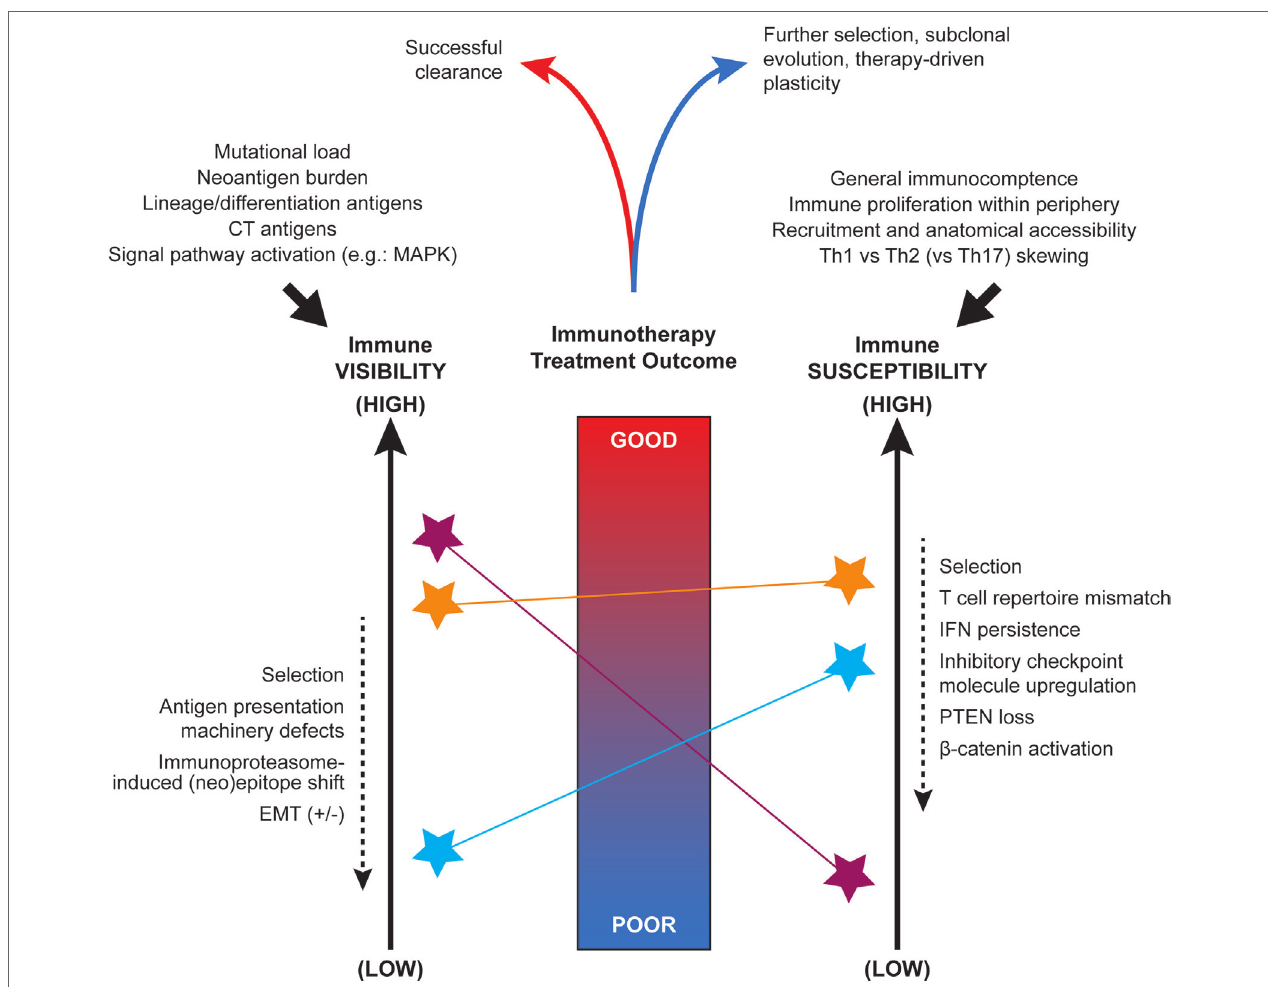
FiGURe 1 | Factors influencing the immune visibility and susceptibility of tumors. Nomogram-conceptualization of the competing influences of tumor immune visibility ( at left ) and the susceptibility of tumor cells to immune attack ( at right ). Due to underlying intra- and inter-tumoral heterogeneity, distinct tumor cell sub-clones or microenvironments ( denoted by colored stars ) may display a range of visibility and susceptibility characteristics that must be integrated when predicting the overall outcome of spontaneous or immunotherapy treatment-induced anti-tumor responses. The initial set-point of immunogenicity is influenced by several factors including somatic mutations, antigen expression, and signal pathway activity ( top left ). The anti-tumor immune set-point is similarly influenced by a number of systemic factors such as availability of immune cell populations for recruitment and Th1 skewing ( top right ). Multiple factors have been implicated as dynamic modulators of these visibility and susceptibility states ( dashed arrows at sides